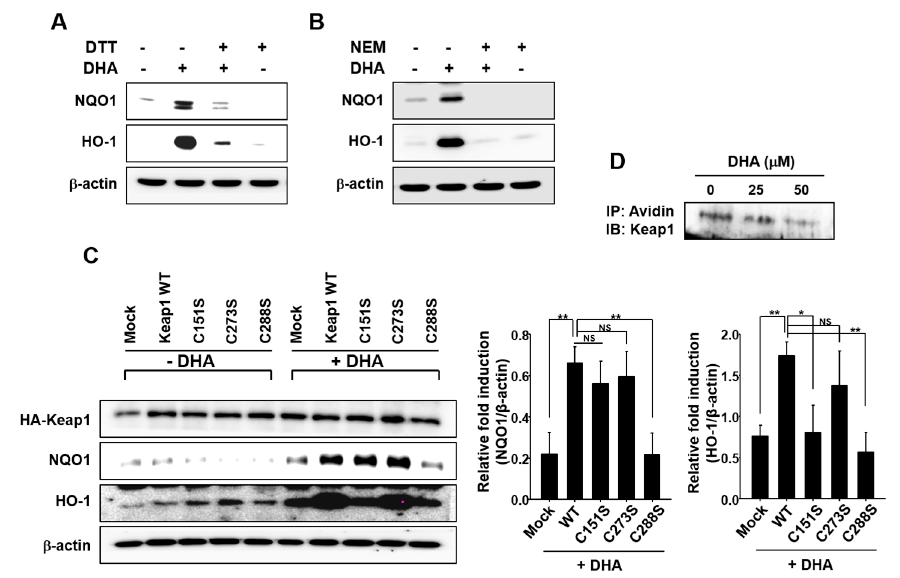
Figure 4. Possible involvement of Keap1 cysteine thiol modification in DHA-induced HO-1 and NQO1 expression. ( A ) MCF-10A cells were pretreated with or without a thiol reducing agent DTT (500 μ M) for 1 h, followed by 18-h incubation with 25 μ M DHA. ( B ) Cells were pretreated with another thiol reducing agent NEM (25 μ M) for 1 h, followed by 18-h incubation with 25 μ M DHA. ( C ) MCF-10A cells were transfected with HA-mock, HA-Keap1 WT, Keap1-C151S, Keap1-C273S, or Keap1-C288S expressing vector for 24 h, and incubated with DHA (25 μ M) for another 9 h to determine the expression of HO-1 and NQO1. HA-Keap1 was used to ensure the equal expression of mutant vectors. Each blot is a representative of three different experiments. Columns, means (n = 3); bars, SD. *, p < 0.05 or **, p < 0.01. NS; non-significant ( D ) MCF-10A cells were incubated with DHA (25 or 50 μ M) for 6 h and then treated with RIPA lysis buffer. Cell lysates were incubated with BPM for 30 min, and then immunoprecipitated with avidin-agarose. The precipitated proteins were subjected to Western blot analysis with an anti-Keap1 antibody.